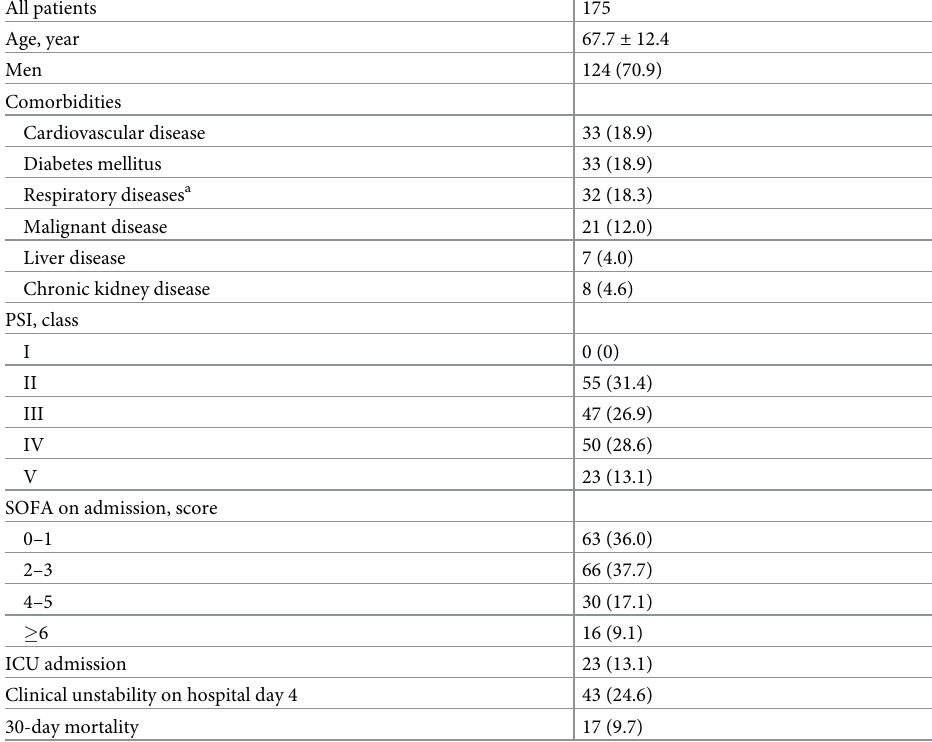
Table 1. Baseline characteristics of all